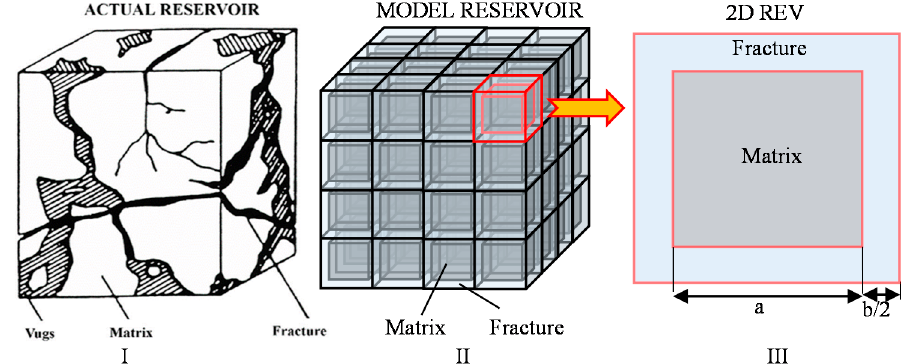
Figure 2. Illustration of the structure of coalbed methane (CBM) reservoir: (I) actual reservoir; (II) model reservoir; and (III) a 2-D sketch of the representative element volume (REV) from the model reservoir.